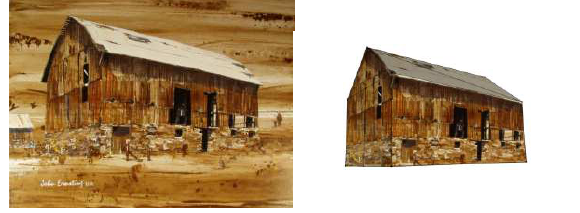
Figure 5: SVR-based 3D building model reconstruction from an acrylics